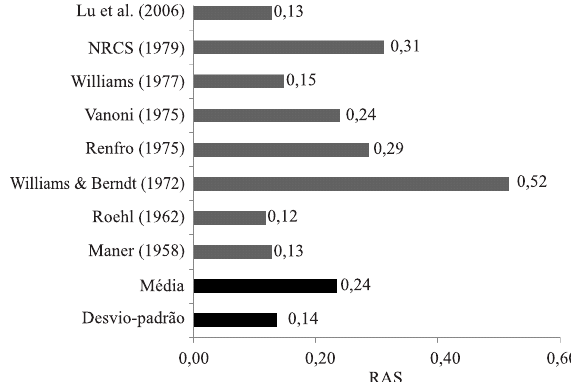
variáveis.Figura 4. Relação de aporte de sedimento (RAS) para a bacia do ribeirão Pipiripau, usando as oito equações do quadro 1.